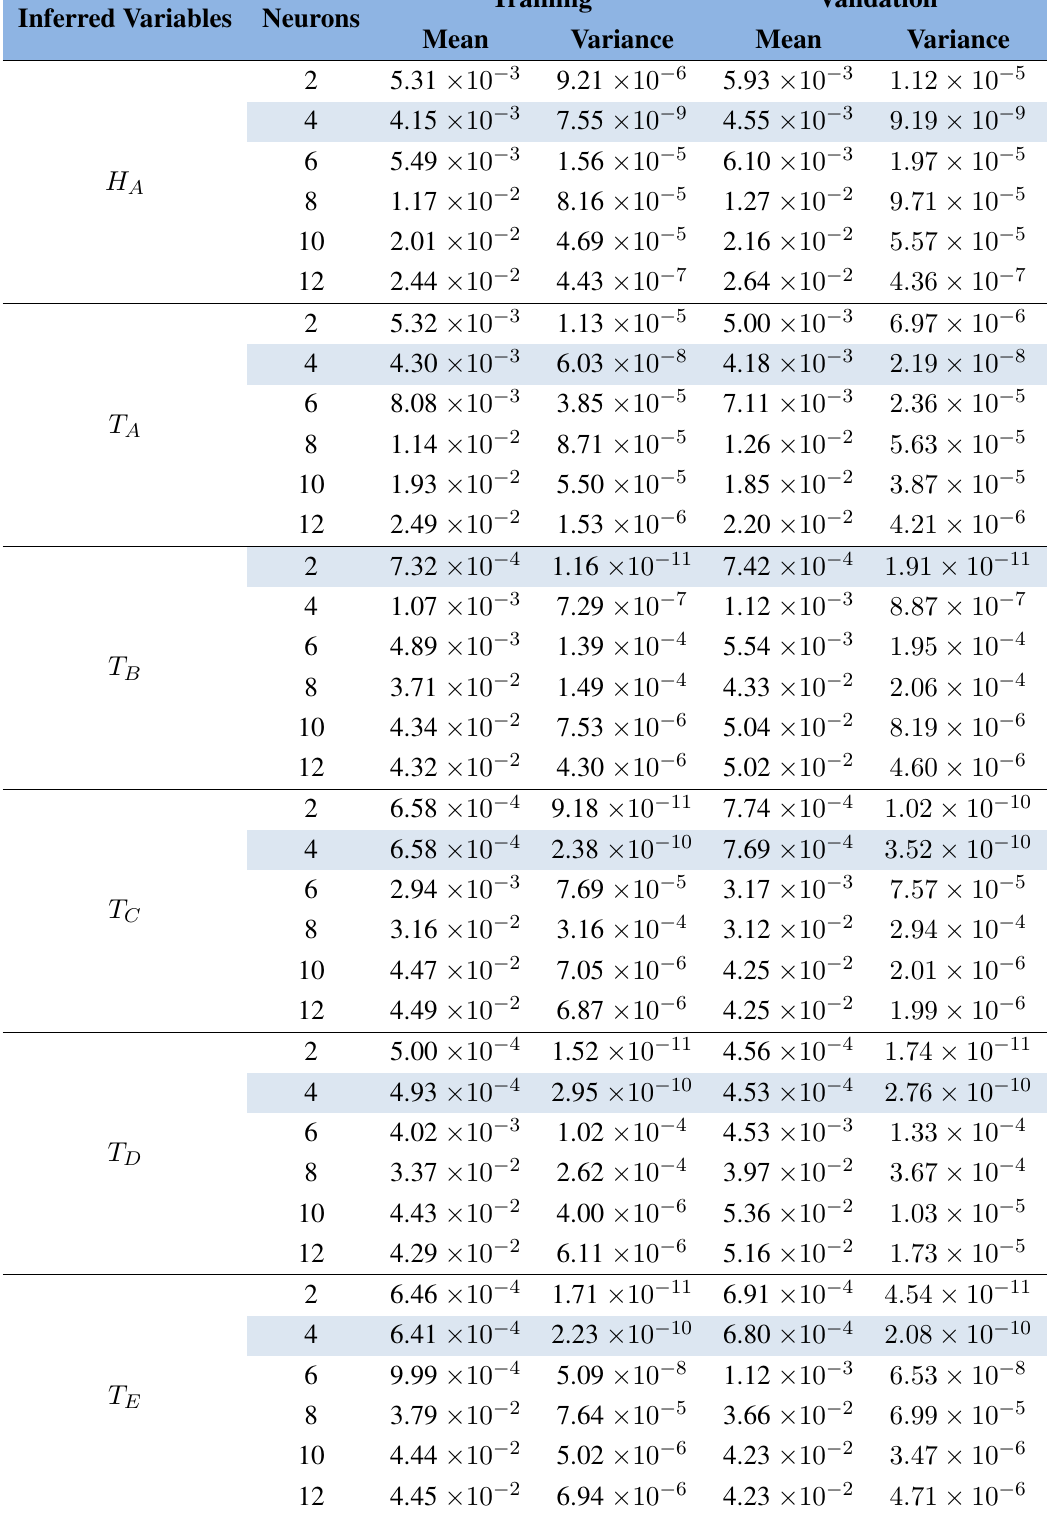
Table 3. Results for the analyzed inference MLP